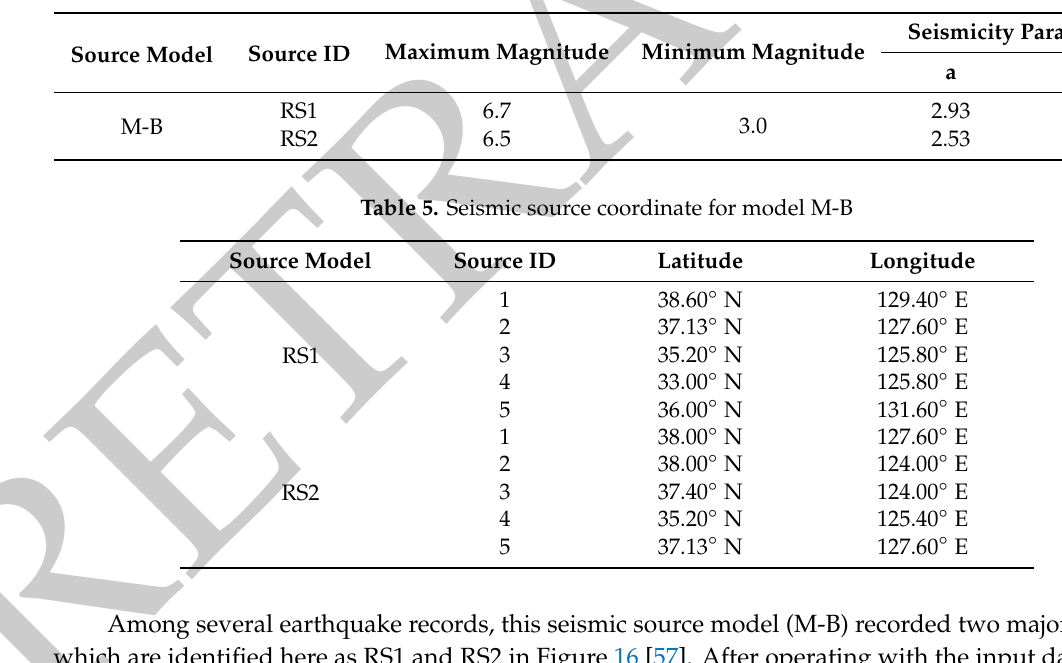
Table 4. Seismicity parameters.